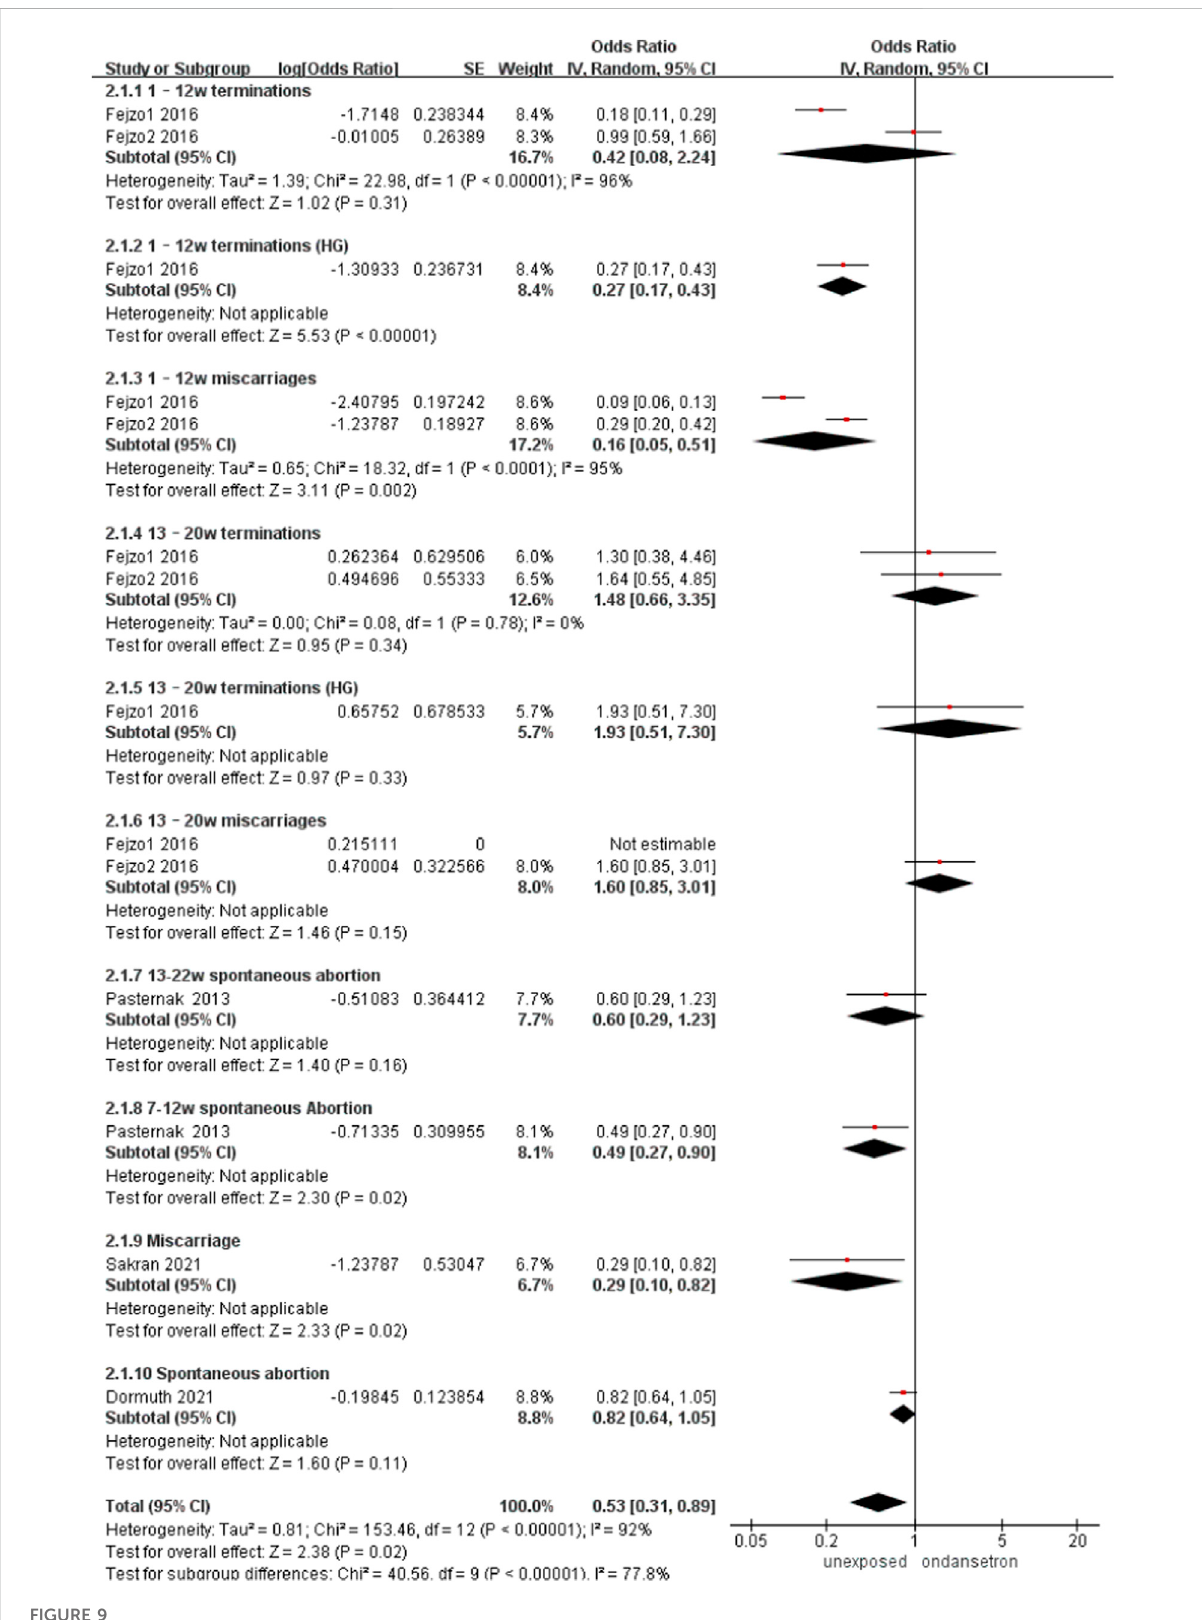
FIGURE 9 Forest plot of